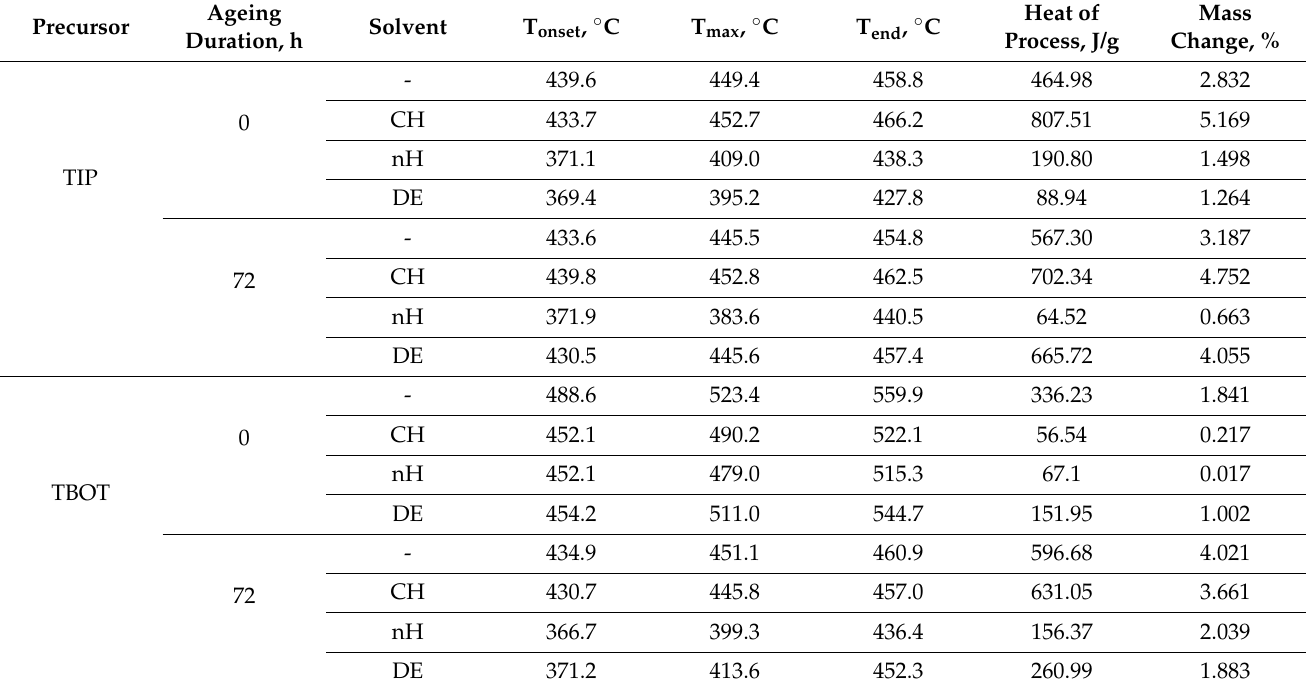
the temperature range of 366–560 °C were formed (Figure 1c,d; Table 1). Such kinds of peaks are characteristic of anatase formation and were observed in all samples [22]. These peaks can be attributed to the conversion of Ti(OH) 4 to TiO 2 (dehydroxylation) and oc- curred during the crystallization of anatase [35,36]. Table 1. The main characteristics of the thermal effects typical of anatase formation.